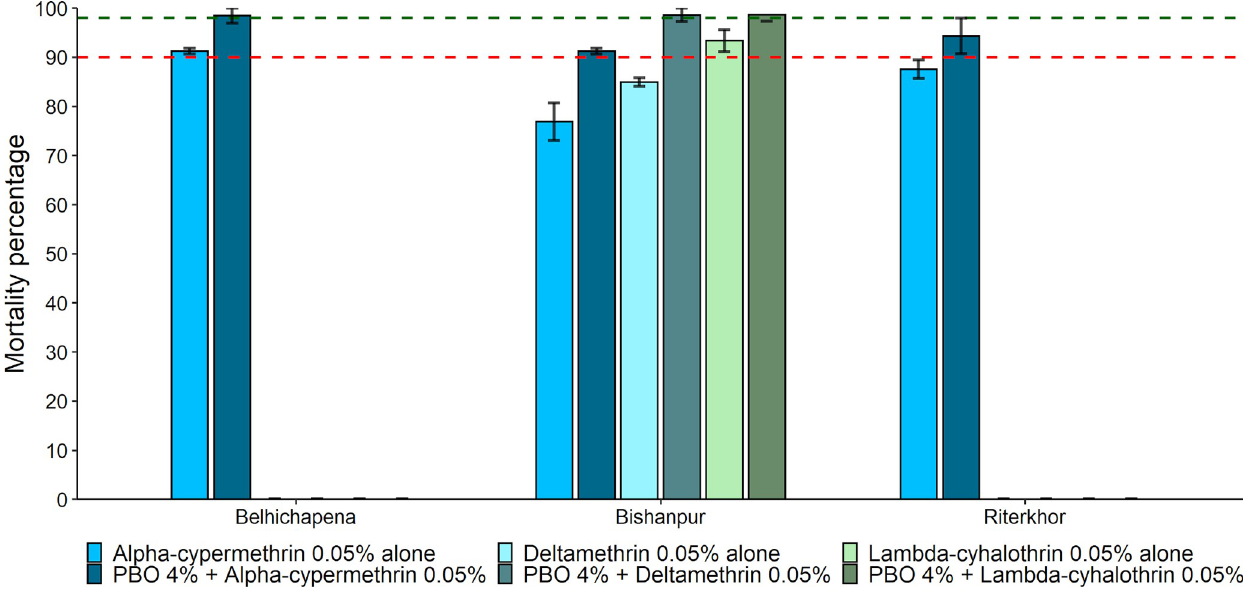
Fig 5. Comparative mortality percentage of P . argentipes to pyrethroid insecticides alone or pre-exposed to PBO 4% papers followed by pyrethroid insecticides. The error bars represent the standard error of the mean. The green-dashed intercept represents the level of 98% mortality; the red dashed intercept represents the level of 90%